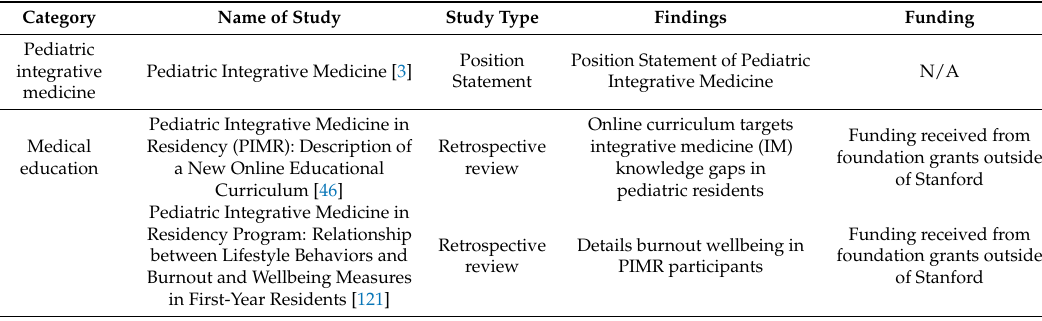
Table 1. Summary of Published Scholarly Work on Integrative